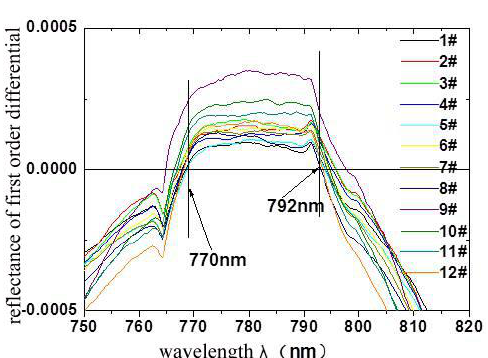
Figure 7. reflectance of first order differential amplifier